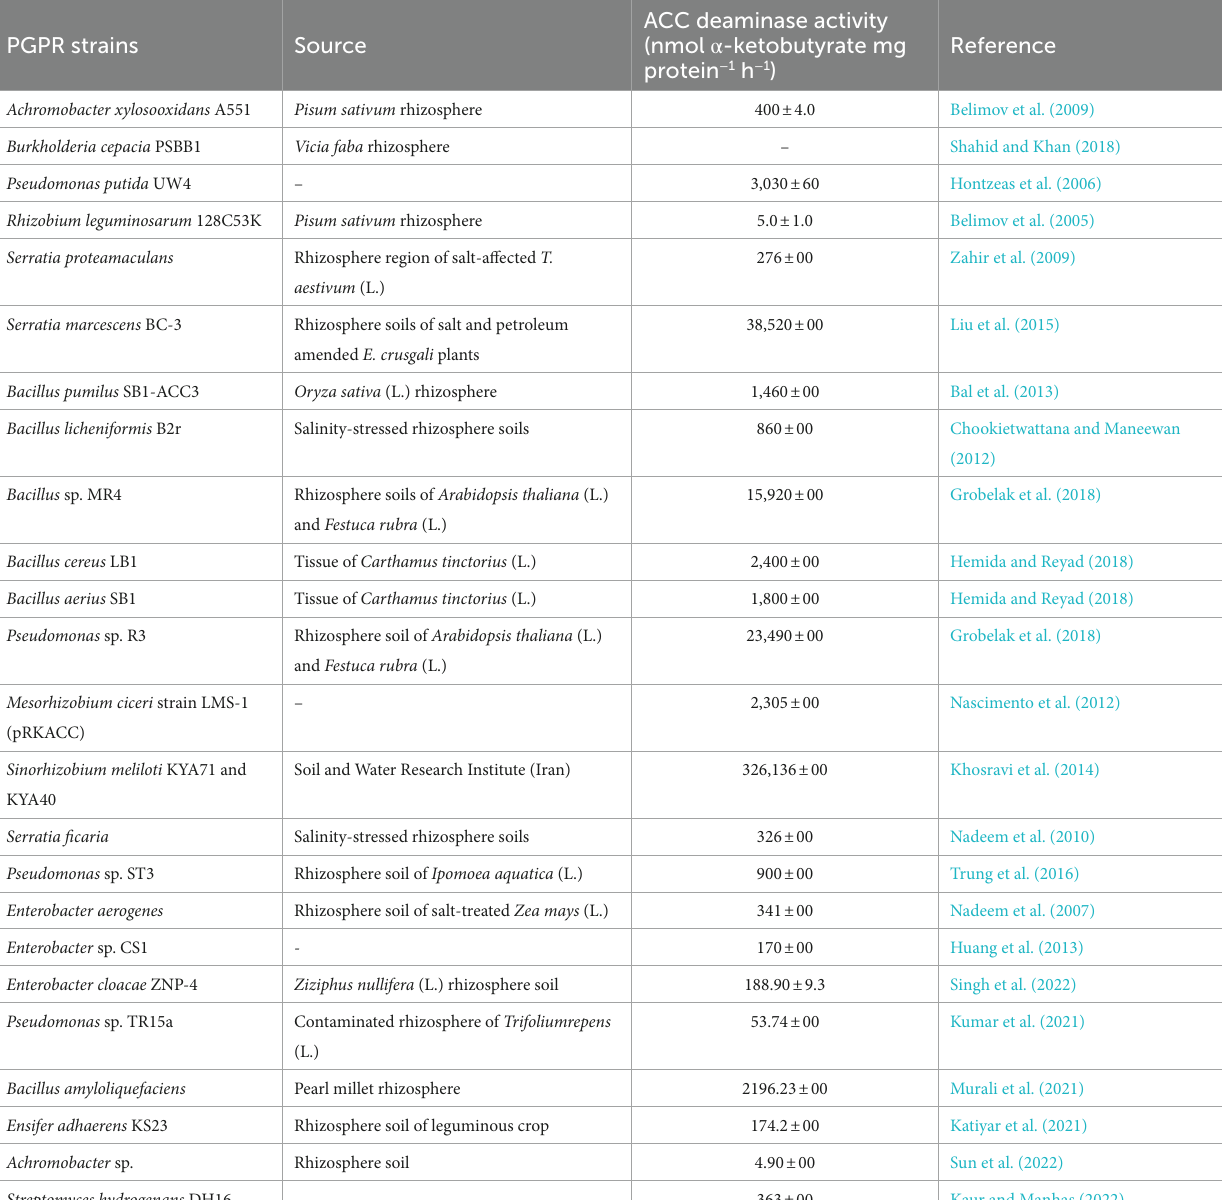
TABLE 1 Examples of ACC deaminase producing